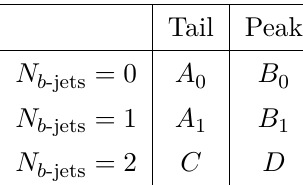
variable and a combination of b -jets